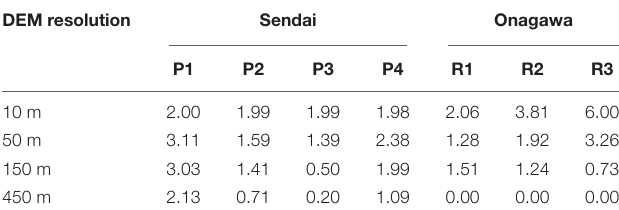
TABLE 1 | Elevations of chosen locations using DEMs of different resolutions